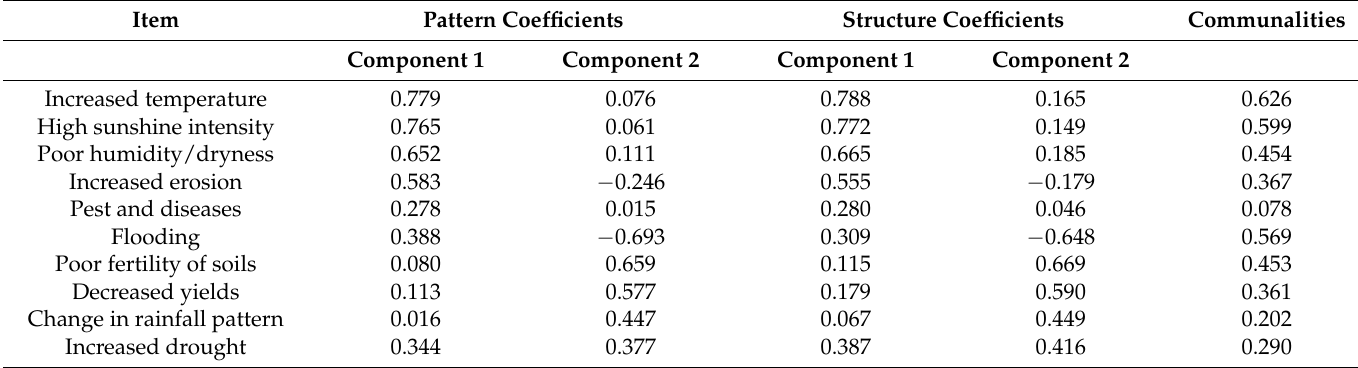
Table A2. Pattern and structure matrix for PCA with Oblimin rotation of a two-factor solution of perception